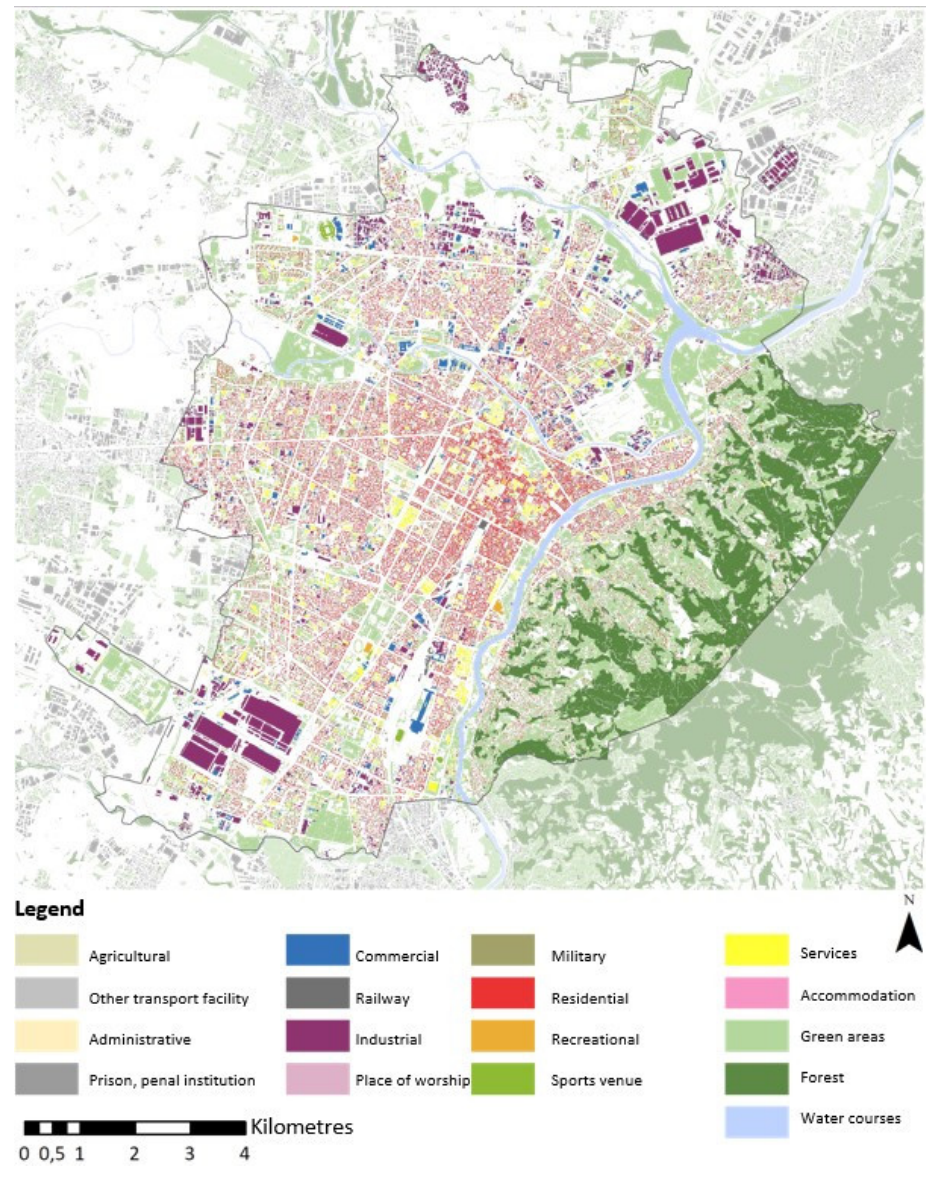
Figure 5. Map of building use categories [29].